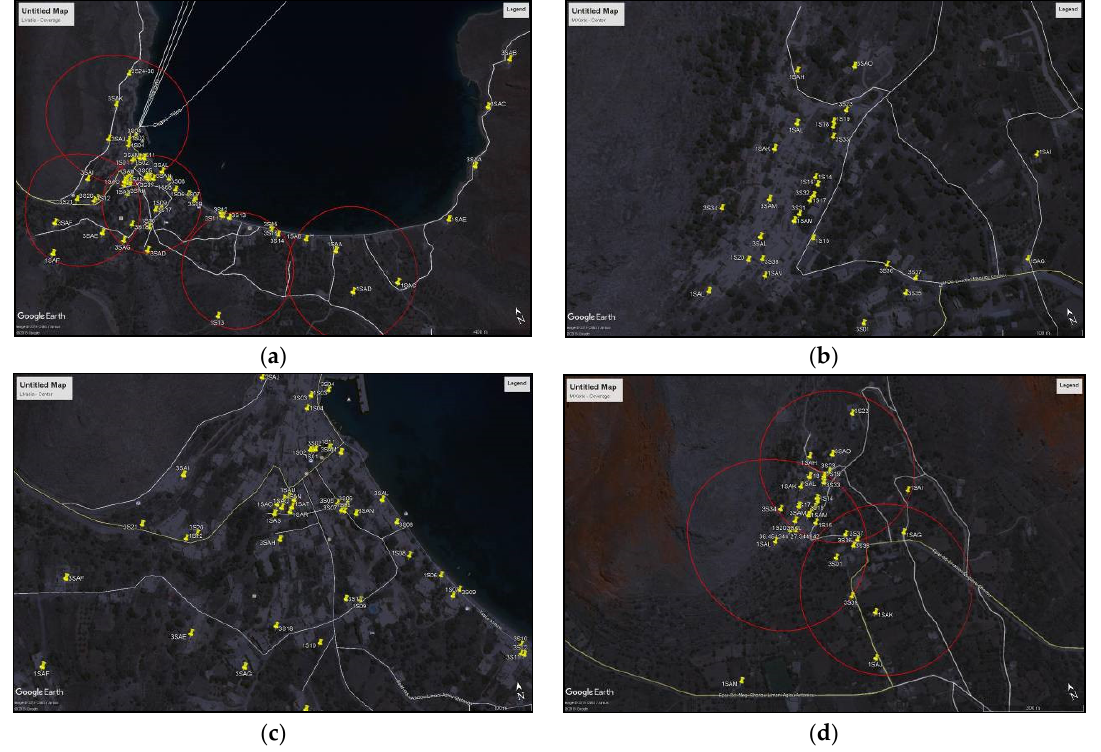
Figure 9. DSM panels—overall and at village centre @ Livadia ( a , b ) and @ M. Chorio ( c , d ).